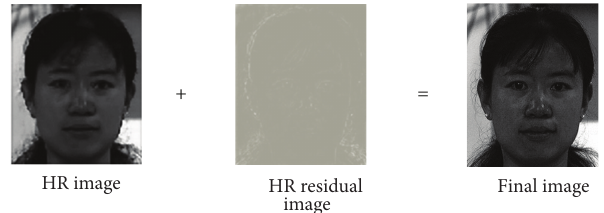
Figure 1: Schematic diagram of face hallucination.